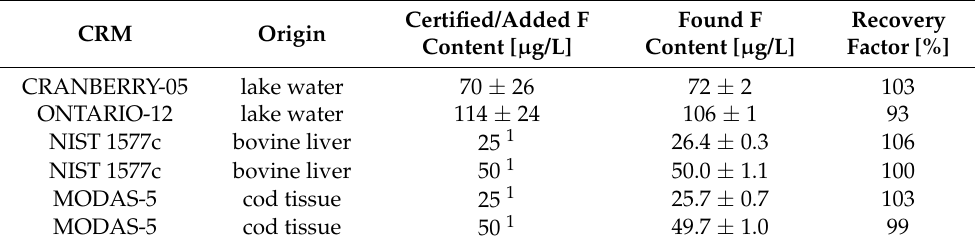
Table 3. Recovery factors for the determination of fluorine in certified reference material of waters and spiked experiment in selected biological certified reference material. CRM